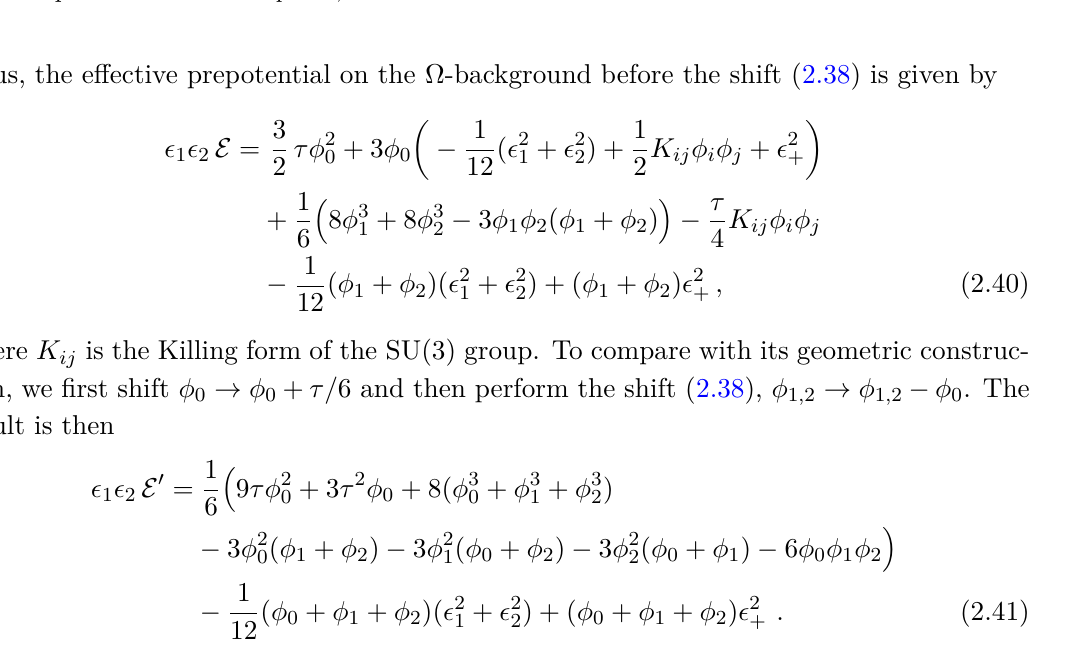
Table 1. Twisted affine Lie algebra ˆ g and invariant subalgebra h under outer automorphism. The superscript ( p ) denotes order p = 2 , 3 of